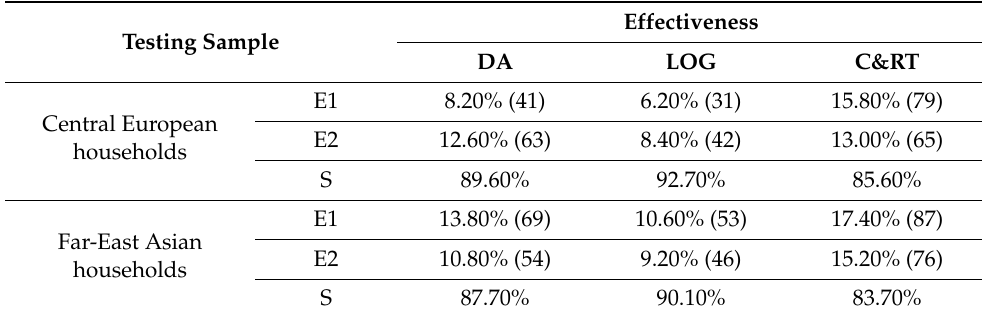
Table 4. The results of the effectiveness of models for Central European and Far-East Asian consumers (testing sample). Source: based on own